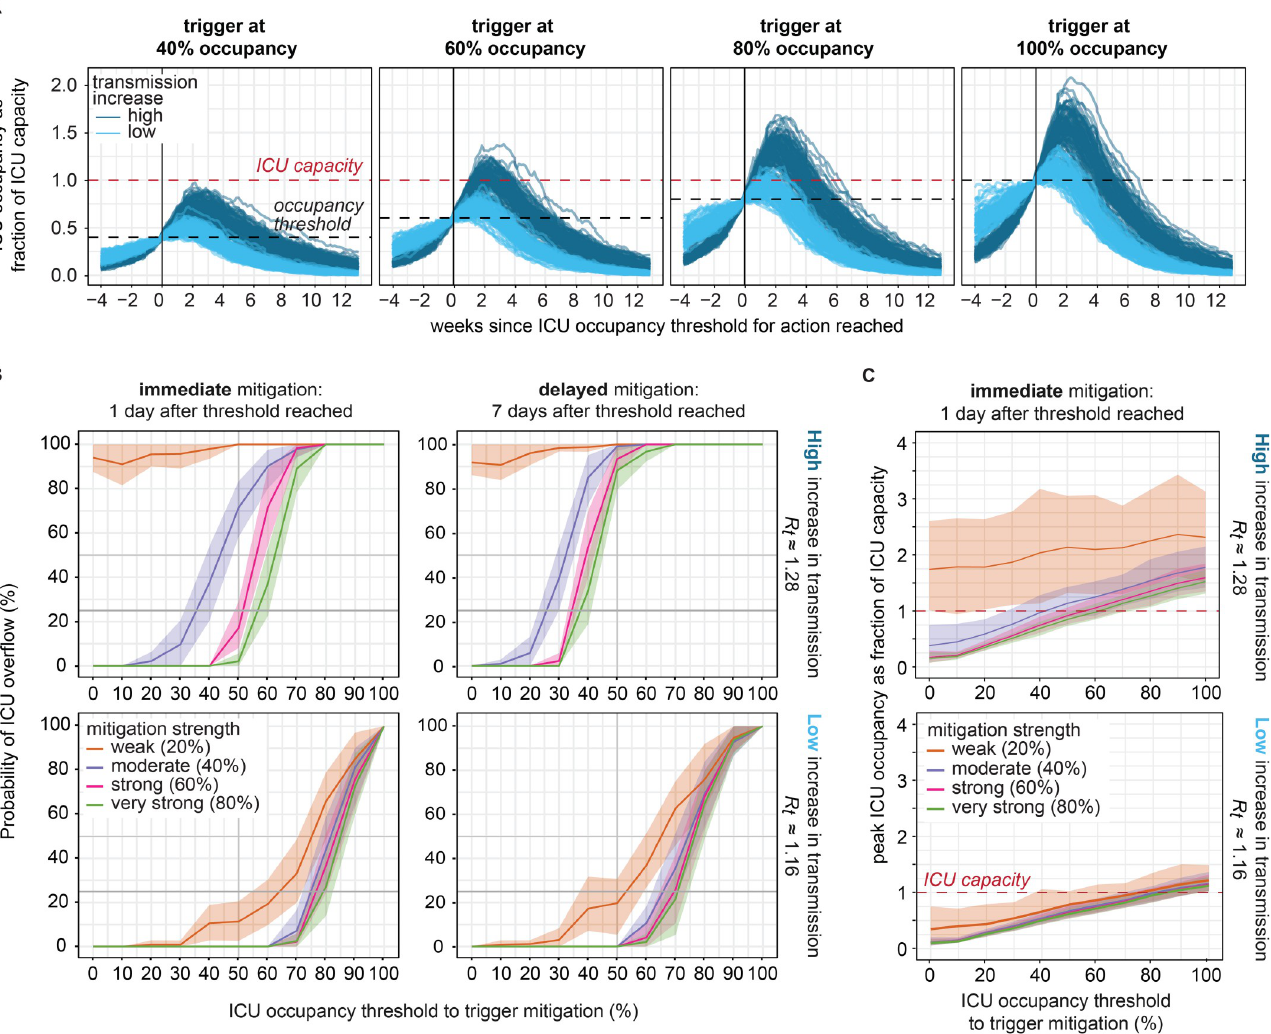
Fig 5. Probability of exceeding ICU capacity by ICU occupancy threshold, mitigation strength and timing. A) Projected ICU occupancy over time under various ICU occupancy thresholds to trigger mitigation. All scenarios show effects of immediate strong mitigation (60% reduction in transmission rate) and include trajectories simulated under either low (light blue) or high (dark blue) levels of transmission increase. B) Probability of ICU overflow under higher (top) or lower (bottom) level of transmission increase and immediate (left) mitigation or delayed (right). The lines and shaded areas show the mean, minimum and maximum probability obtained from resampling 50 trajectories 50 times. C) Peak ICU occupancy by ICU occupancy threshold, mitigation strength, and level of transmission increase, for scenarios of immediate mitigation.